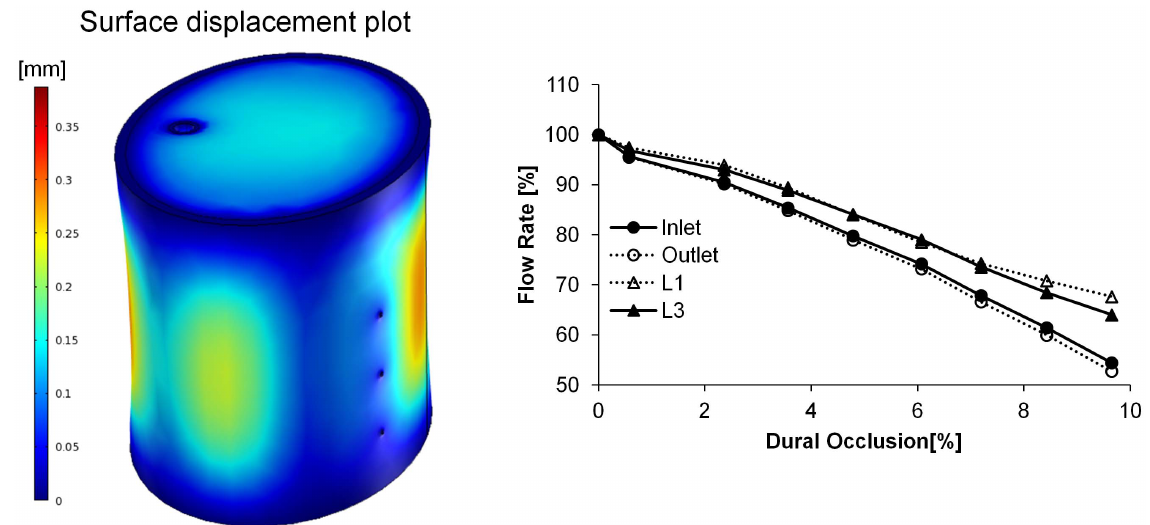
Figure 4. (Left) Representative surface plot of cervical spinal cord displacement under anteroposterior loading. Colorimetric scale represents the induced displacement [mm]. (Right) Retained volumetric blood flow rate under anteroposterior loading. The effect of anteroposterior spinal compression on ASA and branch (L1 and L3) blood flow rates was assessed over the range of 0–9.65% dural occlusion, and the resultant change in arterial blood flow rates were calculated based on the percent of the baseline value (blood flow rate with no compressive loading).